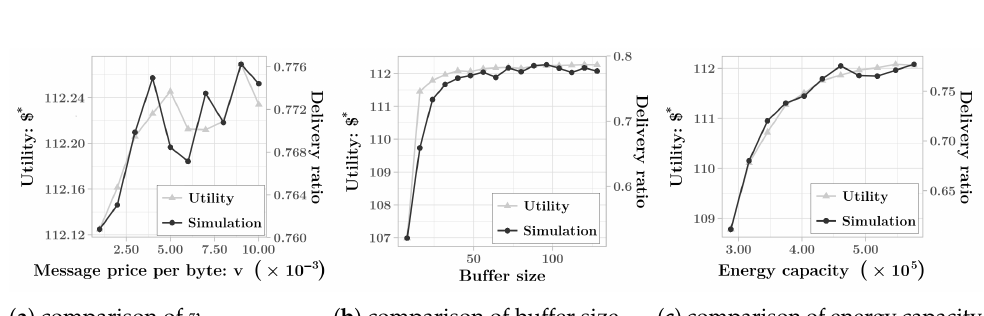
Figure 3. Verification with PRGT.